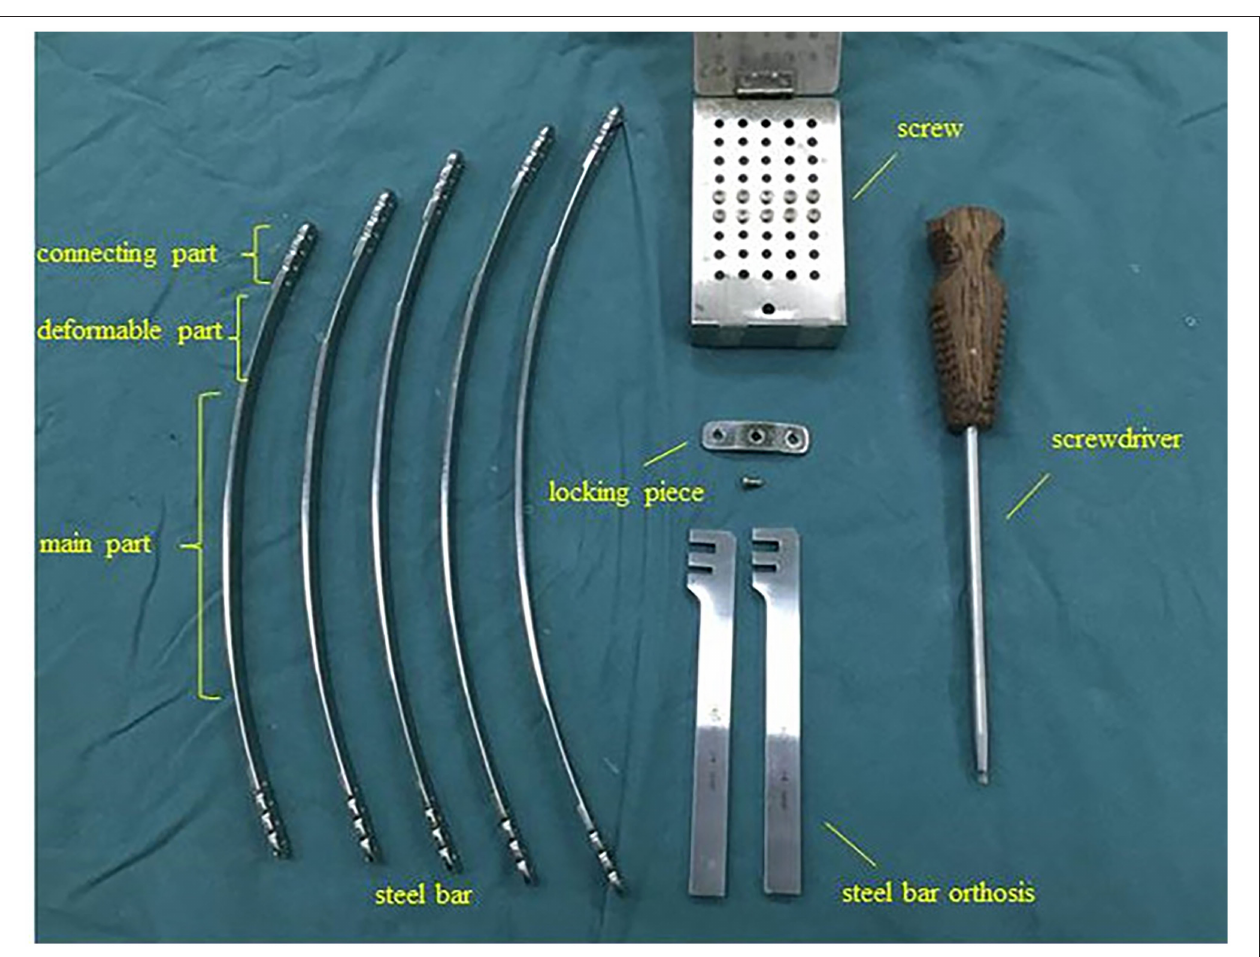
FIGURE 1 | Bar configuration and